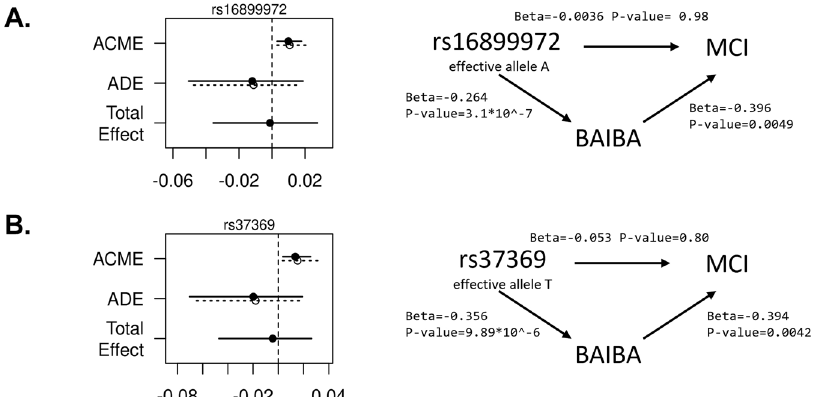
Fig. 3 Visualization of results from mediation analysis using BAIBA. Mediation analysis results for two genetic variants associated with MCI, mediated by BAIBA A rs16899972, B rs37369. Note that the main effect is not signi fi cant as expected by the earlier report of the association between the variant and MCI in set D ( n = 3178), since the mediation analysis was conducted in a smaller sample, similar to Set A ( n = 1490). Effect estimates and p values were obtained from the R median package. ACME average causal mediation effects and ADE average direct